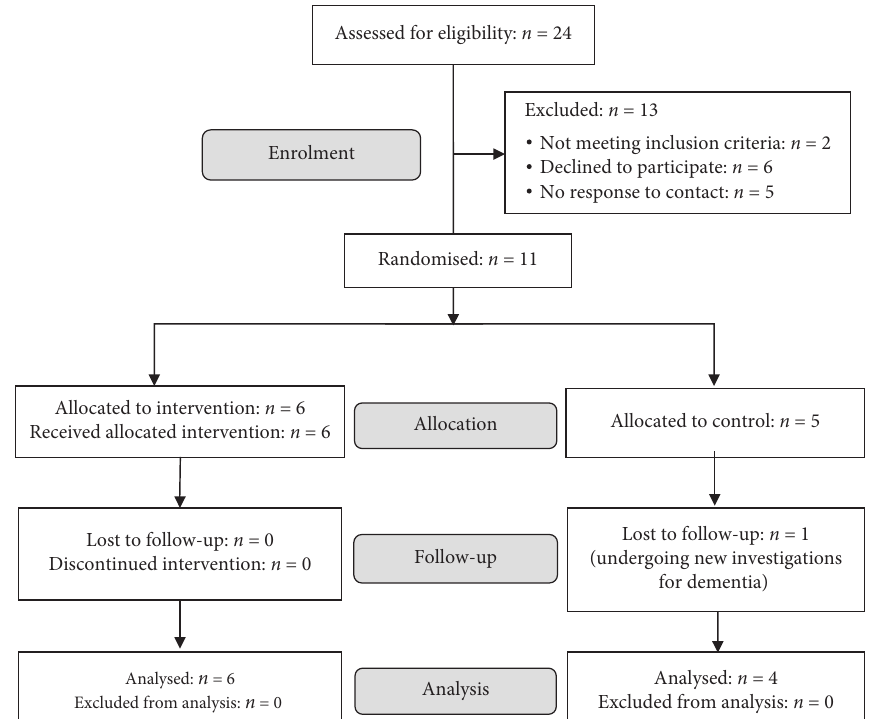
Figure 4: CONSORT diagram showing flow of participants in the pilot